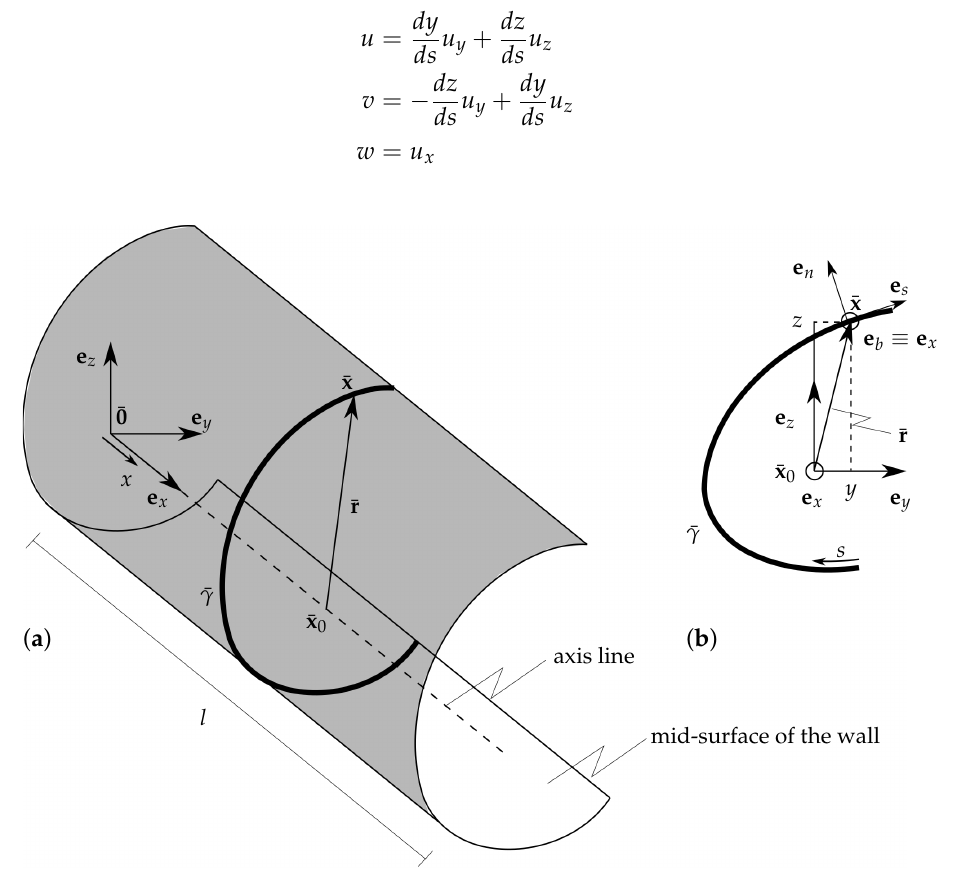
Figure 1. Thin-walled beam in initial configuration ( a ) and details of the mid-curve ¯ γ of the cross-section ( b